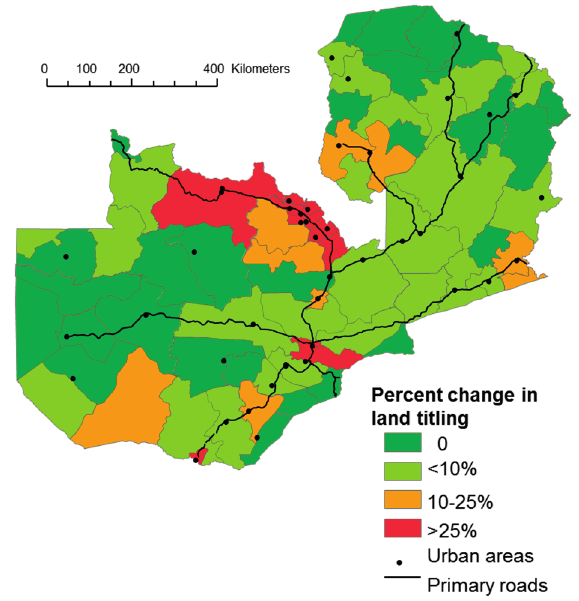
Figure 6. Change in Percent of Farms with Land Title 2001–2012. Source: RALS 2102 and SS